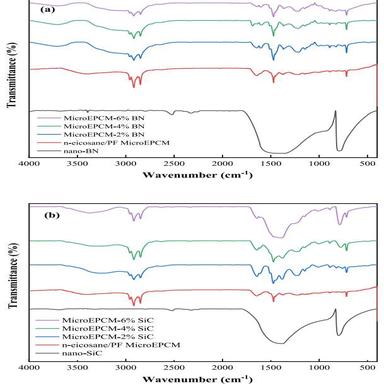
Infrared spectra of (a) MicroEPCM-BN; (b) MicroEPCM-SiC.